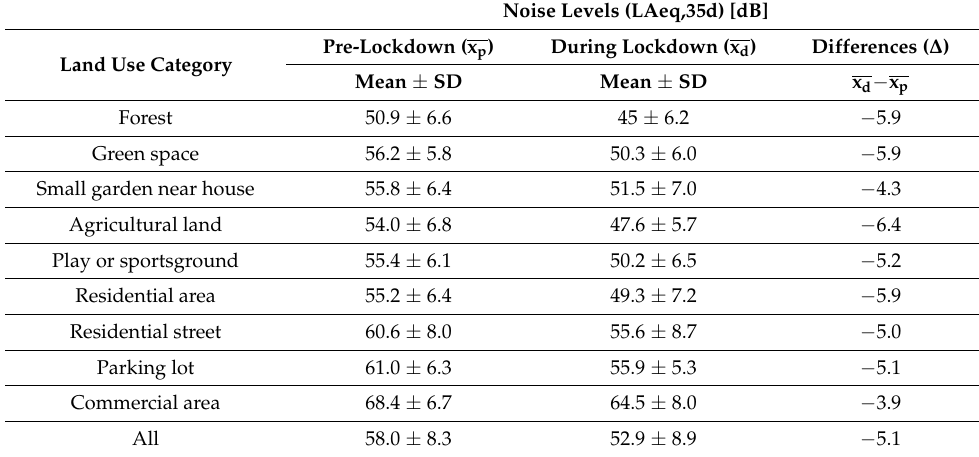
Figure 3. Development of noise levels by land use category. Mean L Aeq , 24h and standard deviation (SD) are shown. Vertical and dashed lines mark 16 and 23 March according to resolved restrictions (s. methods section). Table 1. Mean noise levels (LA eq,35d ) pre- and during (x p and x d ) lockdown and noise differences, overall and by land use